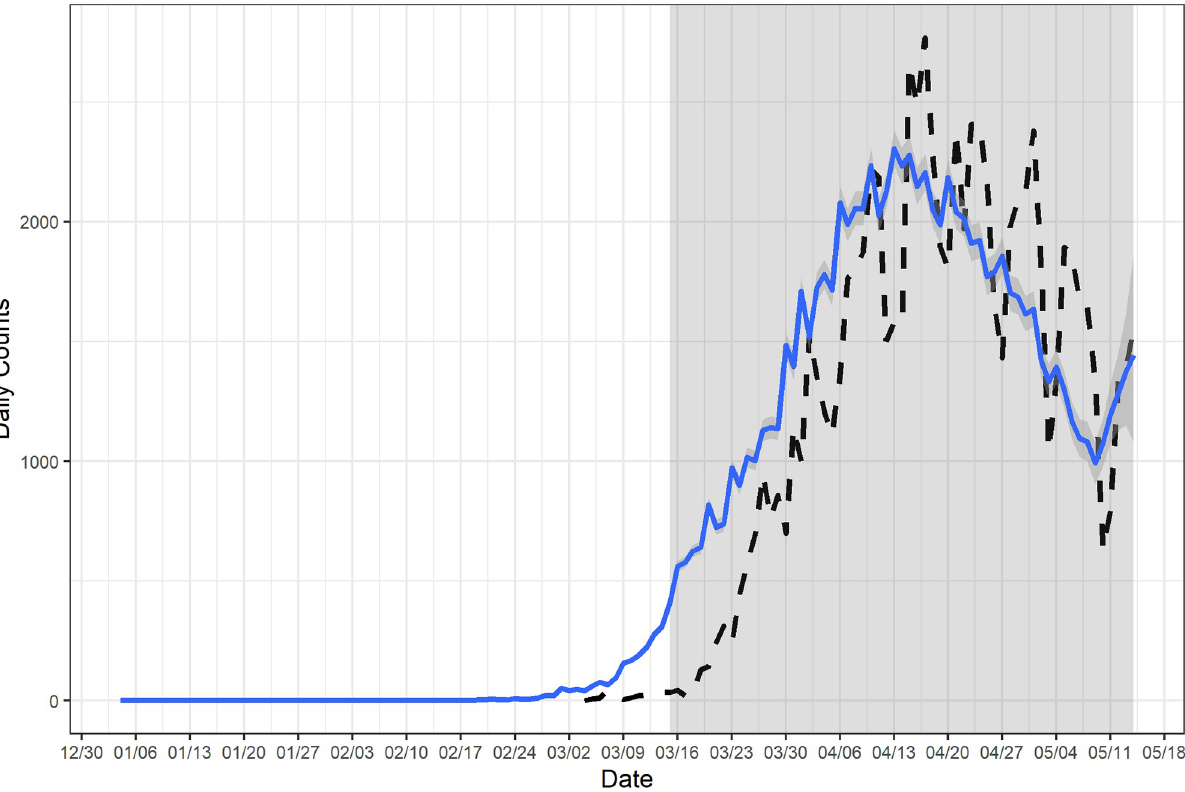
Fig 5. Estimated epidemic curve of COVID-19 in Massachusetts. The estimated epidemic curve was calculated based on weekly smoothing window and l = 60. The line-list data started on March 4, 2020 and ended on May 14, 2020. The earliest possible date that a case showed symptoms was February 1, 2020 and nowcasting started from March 16, 2020. The dashed curve represents the reported